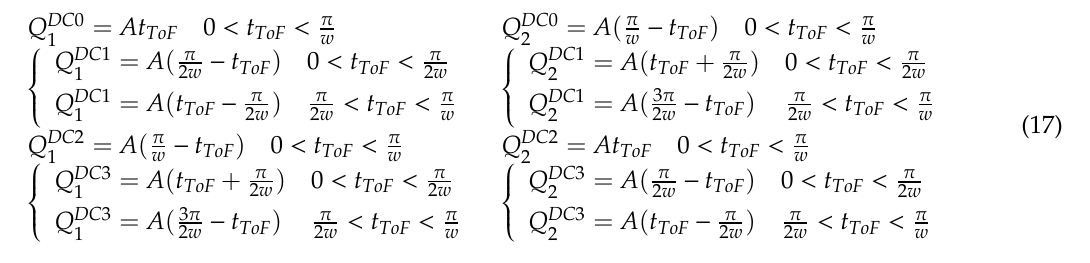
Figure 7. The actual sinusoidal modulation signal and its Fourier transform. ( a ) Actual sinusoidal modulation signal. ( b ) Fast Fourier transform of the sinusoidal modulation signal. Different from Section 2.1, the sampling process is modified as Equation (17):